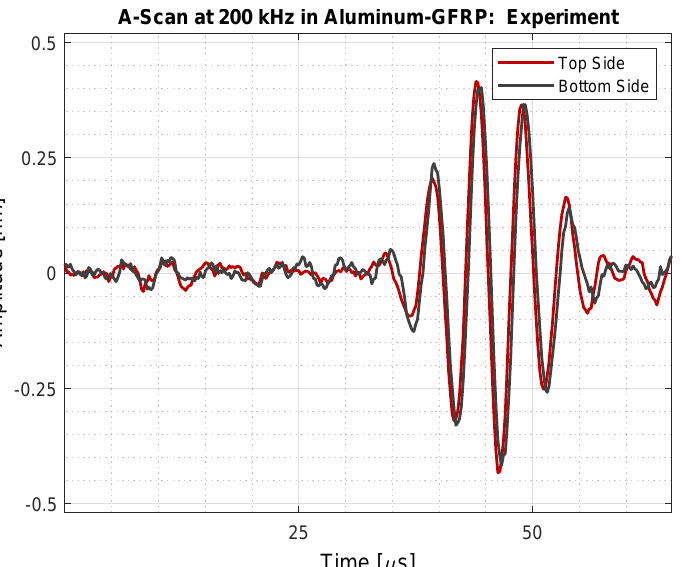
Figure 10. The captured time signals in the aluminum-GFRP plate on the top and bottom surface at